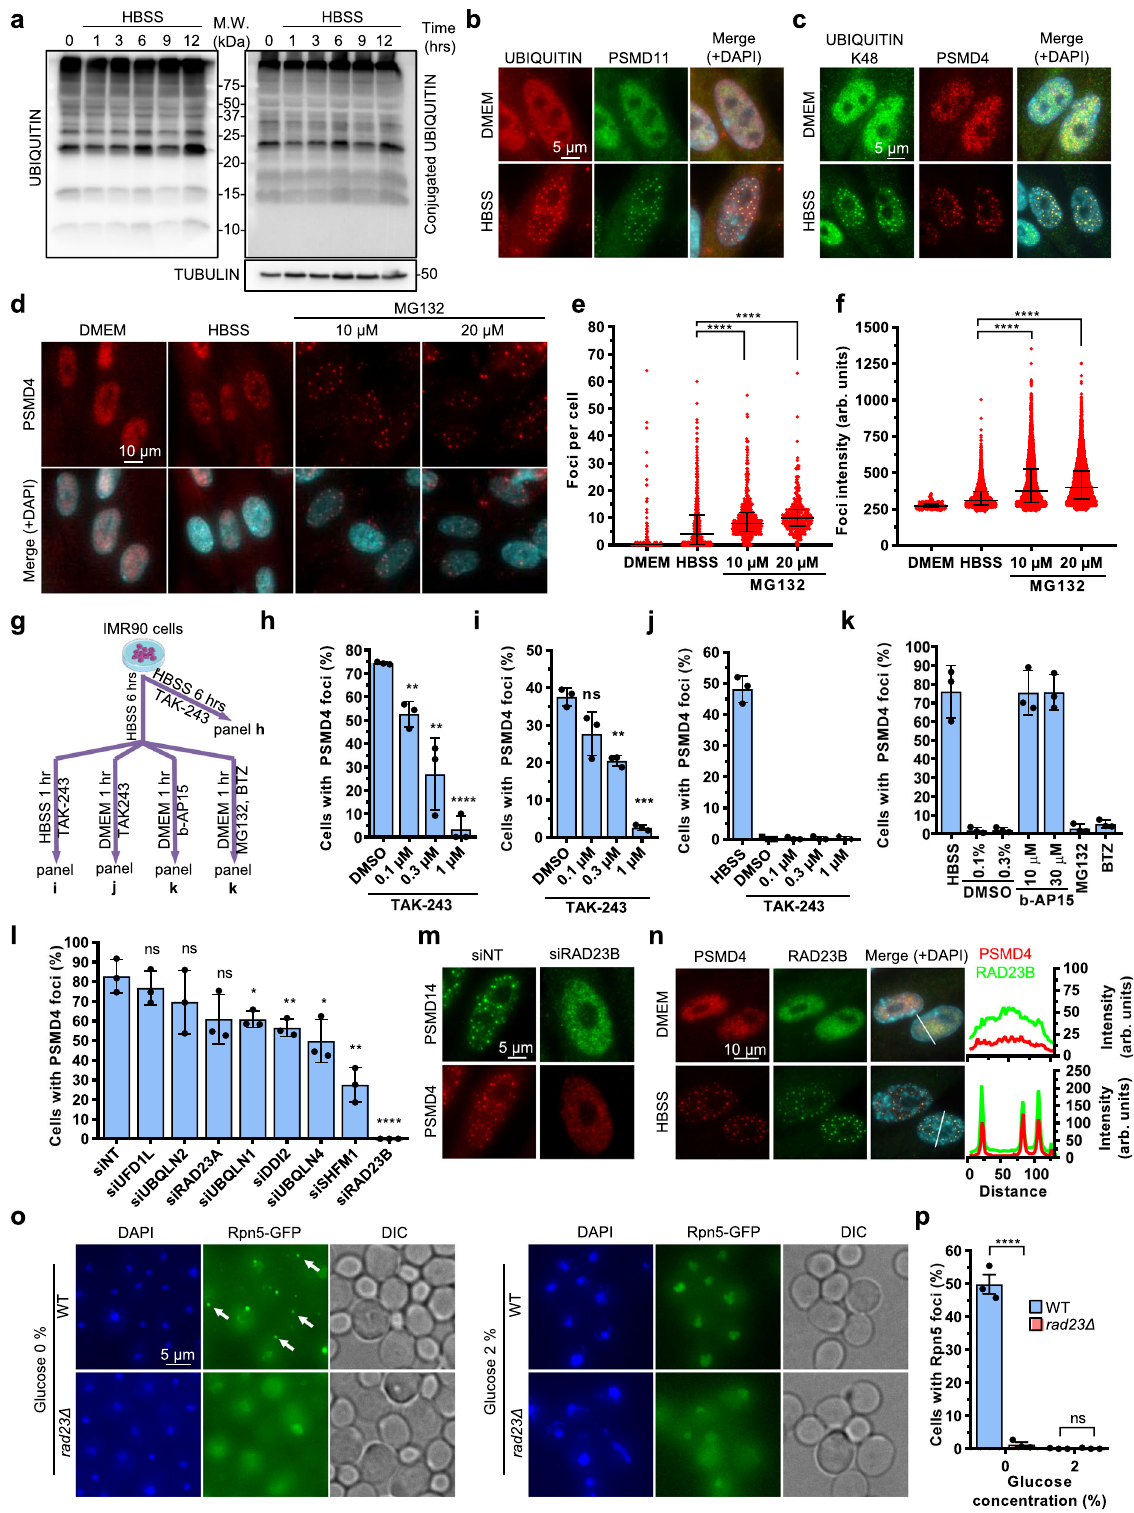
Methods Plasmids . The cDNAs of human PSMB4 , PSMB5 , PSMD14 , and PSMD12 genes were generated in a modi fi ed pBluescript using gene synthesis (Biobasic). The constructs were then subcloned as a fusion with the GFP gene and recombined using gene LR-clonase in lentiviral expression vectors as previously described 58 . SiRNA-resistant constructs for human RAD23B and its corresponding mutants RAD23B Δ UBL, RAD23B Δ UBA1, RAD23B Δ UBA2, RAD23B Δ UBA1/UBA2, and RAD23B Δ STI were generated using gene synthesis (Biobasic) and then